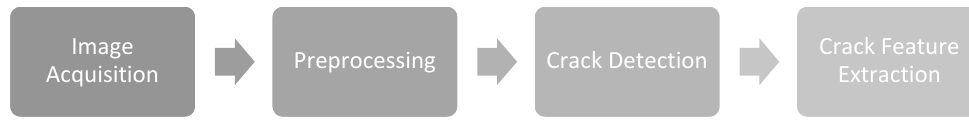
Figure 1. Image Processing Methods for Crack Detection .